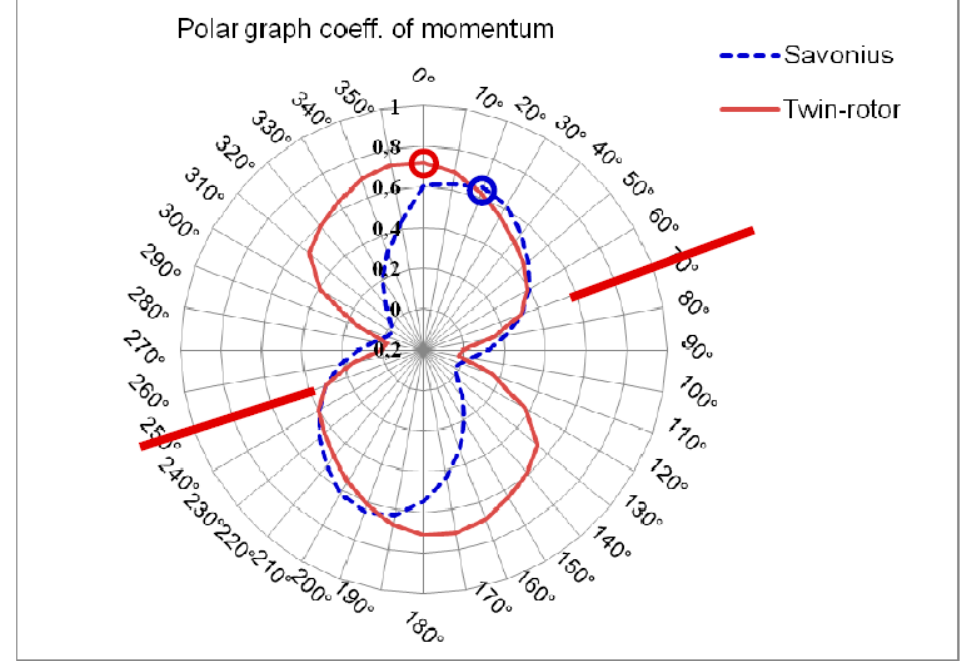
Figure 12. Rotor moment change during rotation for both wind turbines.